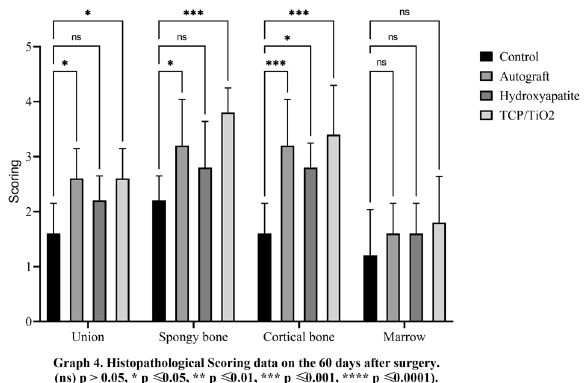
Fig. 1 Histopathological scoring data on the 15 days after surgery. (ns) p > 0.05, * p ≤ 0.05, ** p ≤ 0.01, *** p ≤ 0.001, **** p ≤ 0.0001